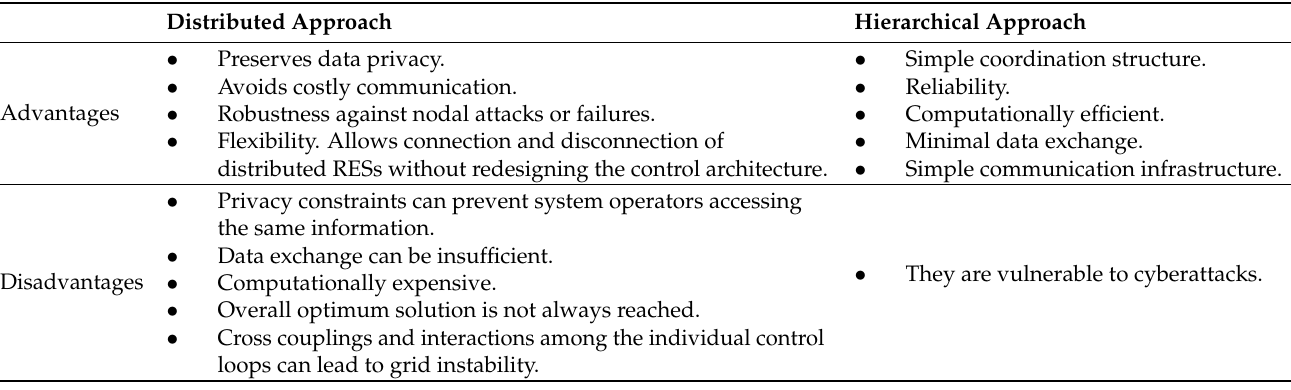
Table 8. Main advantages and disadvantages of distributed and hierarchical